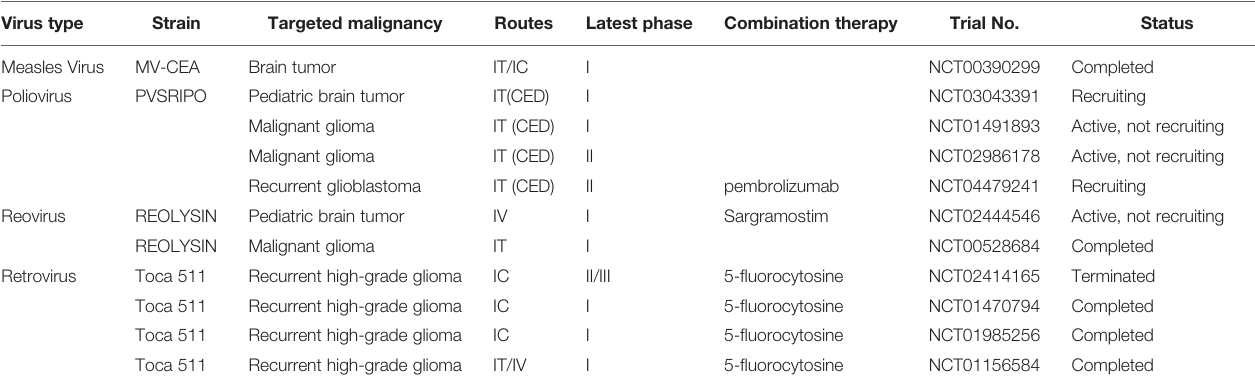
TABLE 3 | Current clinical trials utilizing RNA viruses against